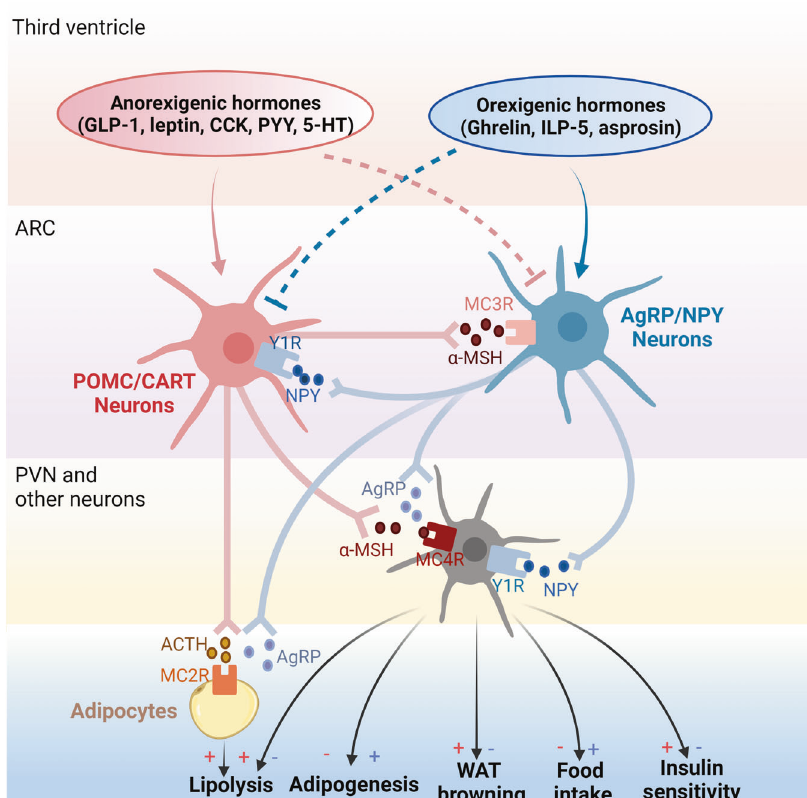
Fig. 6 Melanocortin pathway in obesity pathogenesis. The melanocortin pathway consists of POMC; melanocortin receptors MC1R-MC5R; and agouti and AgRP. POMC/CART neurons in ARC are stimulated by anorexigenic hormones in the third ventricle like GLP-1, leptin, CCK, PYY, and 5-HT, while suppressed by orexigenic hormones like Ghrelin, ILP-5, and asprosin. Upon stimulation, POMC/CART neurons secrete POMC including α -MSH and ACTH. α -MSH is released into the PVN. By interacting with MC4R, α -MSH activates PVN neurons and displays anti-obesity effects by inhibiting adipogenesis, promoting lipolysis, inducing WAT browning, reducing food intake, and improving insulin sensitivity. ACTH released by POMC/CART neurons actions on adipocytes directly by binding to MC2R, further promoting lipolysis. However, these effects can be abolished by AgRP, which is the endogenous antagonist of POMC and is secreted by AgRP/NPY neurons in ARC. Conversely, AgRP/NPY neurons can be stimulated by orexigenic hormones in the third ventricle but inhibited by anorexigenic hormones. Notably, POMC/CART and AgRP/NPY neurons interact mutually. NPY receptor Y1R is expressed in POMC/CART neurons and its activation inhibits POMC neurons in the ARC. In contrast, MC3R expressed in AgRP/NPY neurons seems to increase food intake in an “ AgRP circuitry ” -dependent